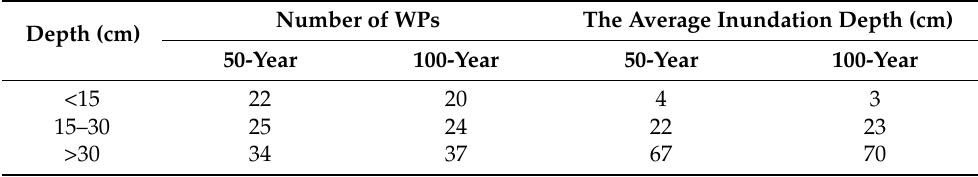
Table 3. Simulation results of waterlogging points for different depths. Number of WPs The Average Inundation Depth Depth (cm)